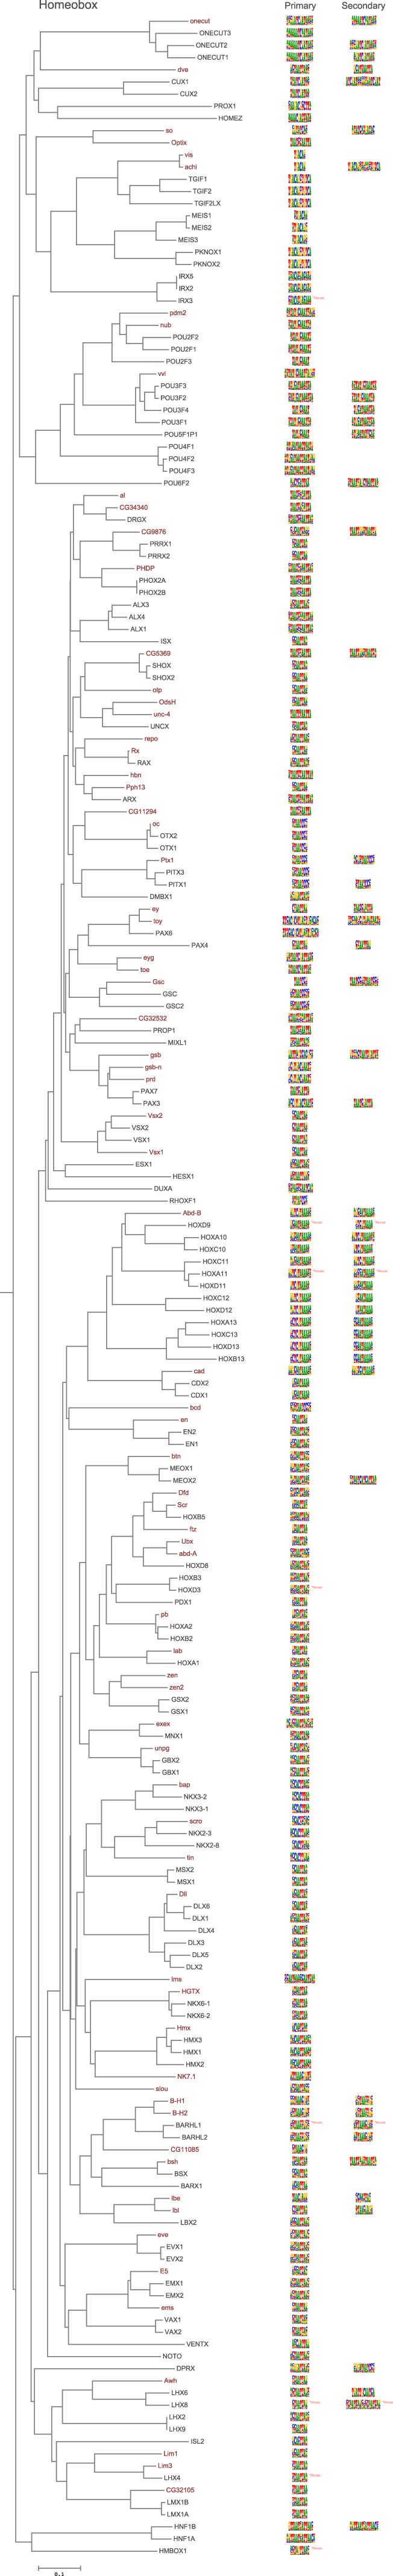
Amino-acid sequence similarity dendrograms for major TF families (human, mouse and Drosophila) annotated with Homeobox motifs obtained using HT-SELEX.Drosophila TFs are in red typeface. Left and right columns indicate primary and secondary motif respectively.